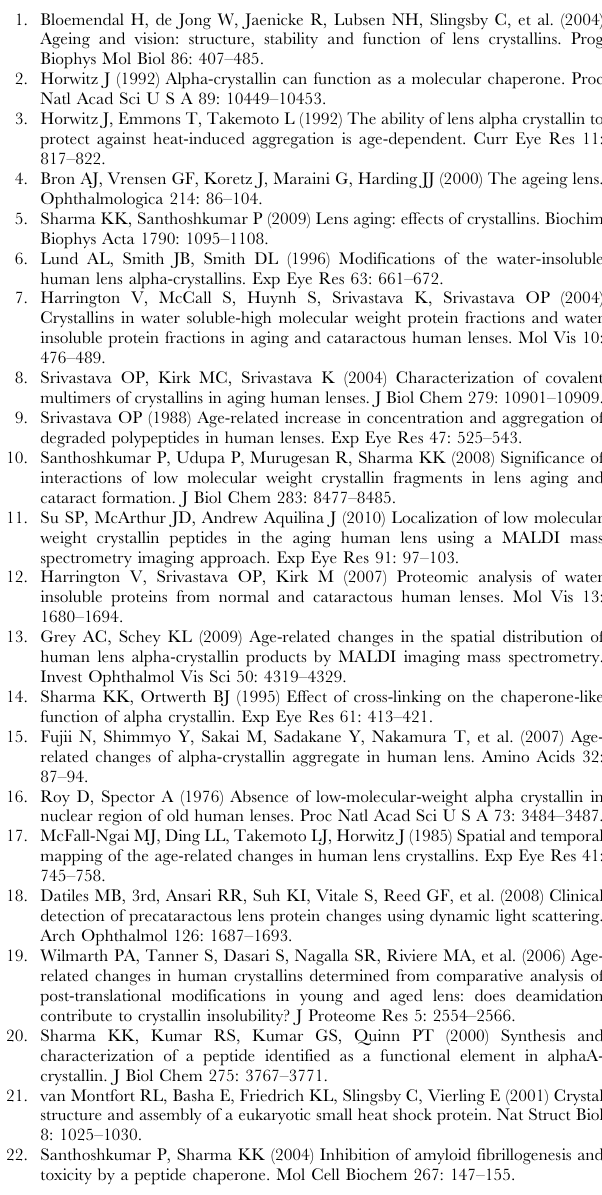
show that a A-(66-80) peptide does not form fibrils in the presence of ADH, a A-crystallin or HLE that has structure similar to that of fibrils formed by the peptide. Figure S7 Anti-chaperone activity of the a A-(66-80) peptide against bovine a -crystallin in the ADH aggrega- tion assay. Aggregation assay was carried out, as described earlier [10], after incubation of a -crystallin with the peptide for 35 min at 37 u C. The results show that the a A-(66-80) peptide is capable of suppressing the chaperone activity of a